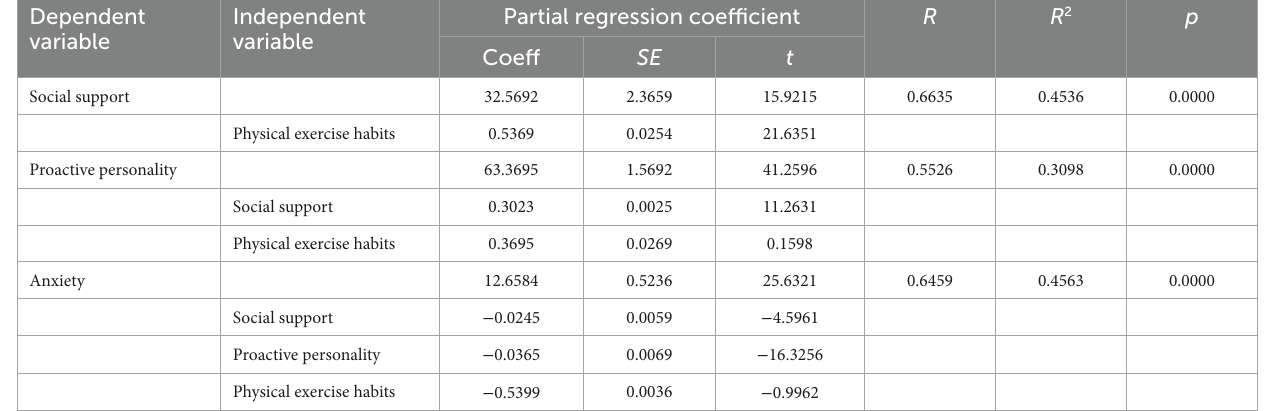
TABLE 6 Regression analysis of physical exercise habits, anxiety, social support, and proactive personality. Dependent variable